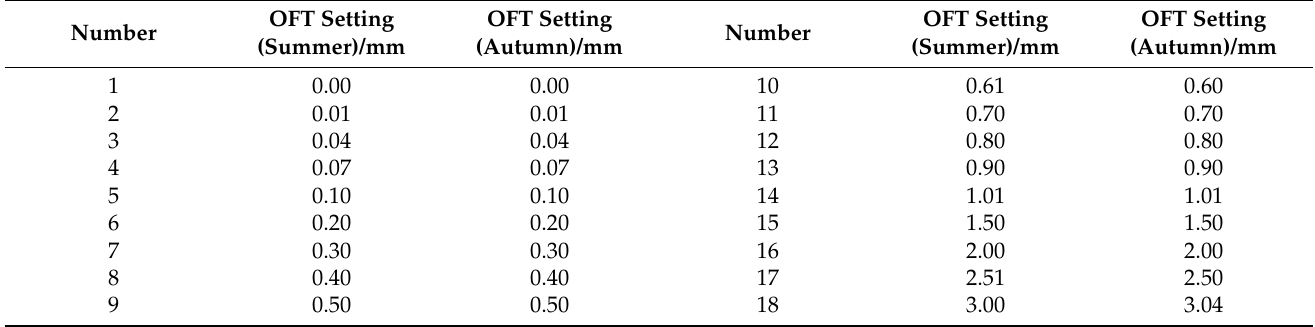
Table 1. Oil film thickness Table 1. Oil fi lm thickness se tt ing.